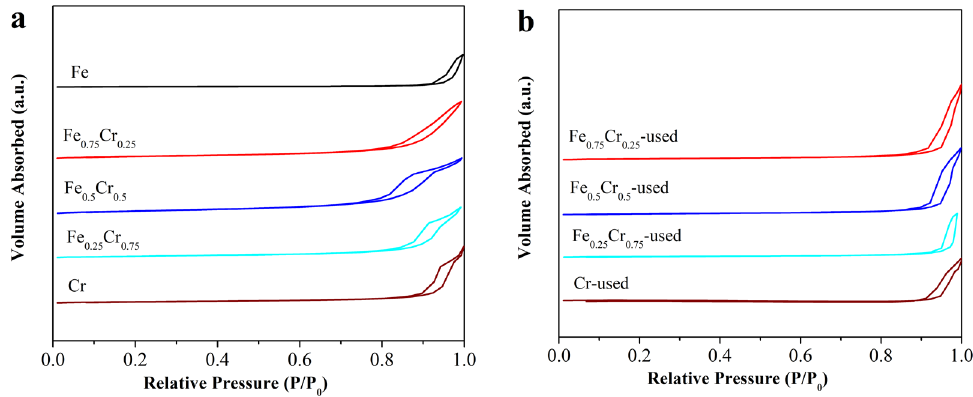
Figure 1. N 2 adsorption–desorption isotherms of ( a ) fresh, and ( b ) used FeCrO x catalysts. The powder XRD data of the fresh samples are shown in Figure 2. The